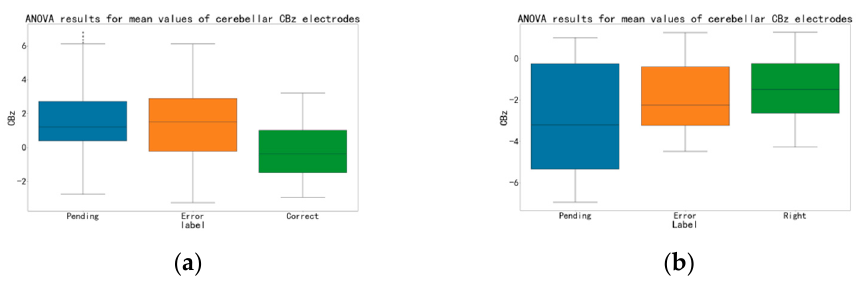
Figure 9. ( a ) The ANOVA result of each condition of the subject 03 electrode C4. ( b ) The ANOVA result of each condition of the subject 03 cerebellar electrode CBz.